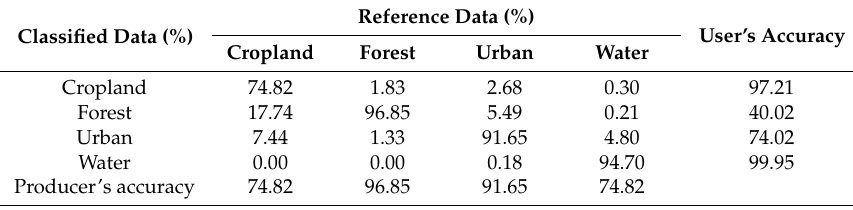
Table 5. Confusion matrix of classification results from the CCDC